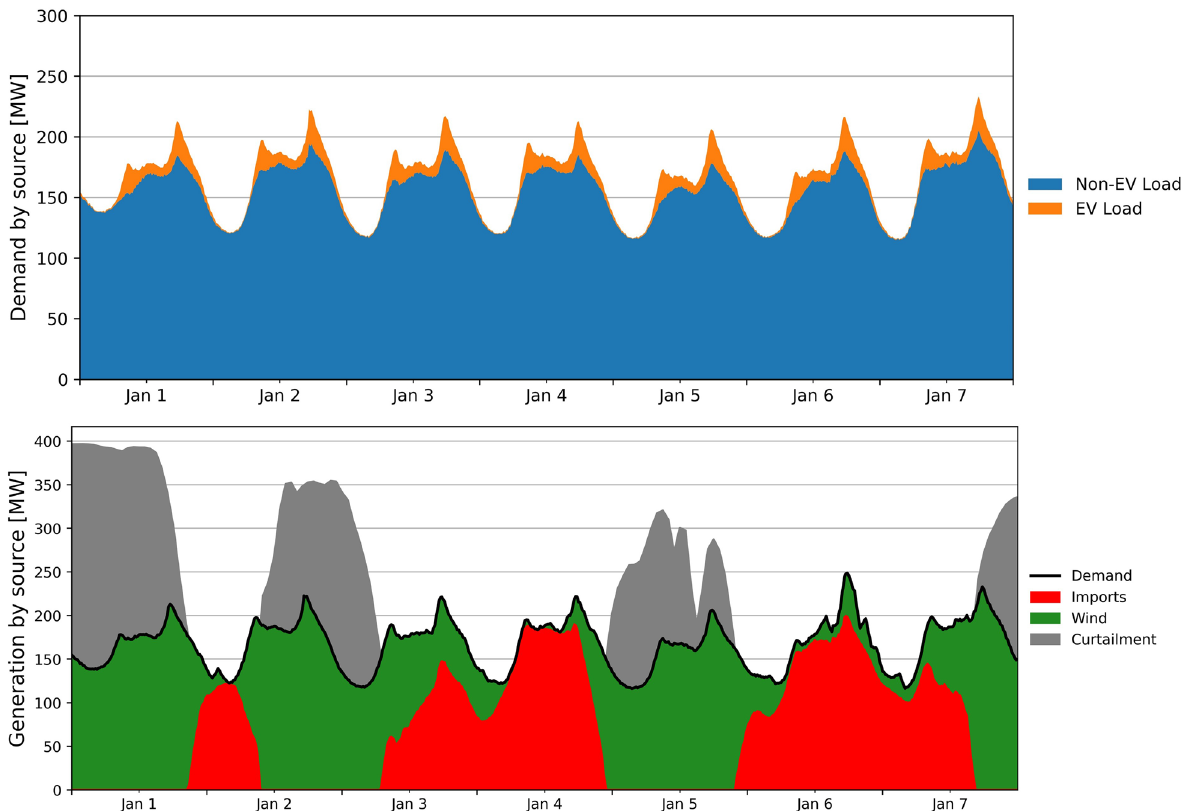
Fig. 5 Regina’s electricity demand for wind-only configuration with UNC in January, shown by a demand type (top) and b generation type (bottom). Note that “imports" refer to electricity supply from the provincial grid, which have been aggregated by generation type but include coal and natural